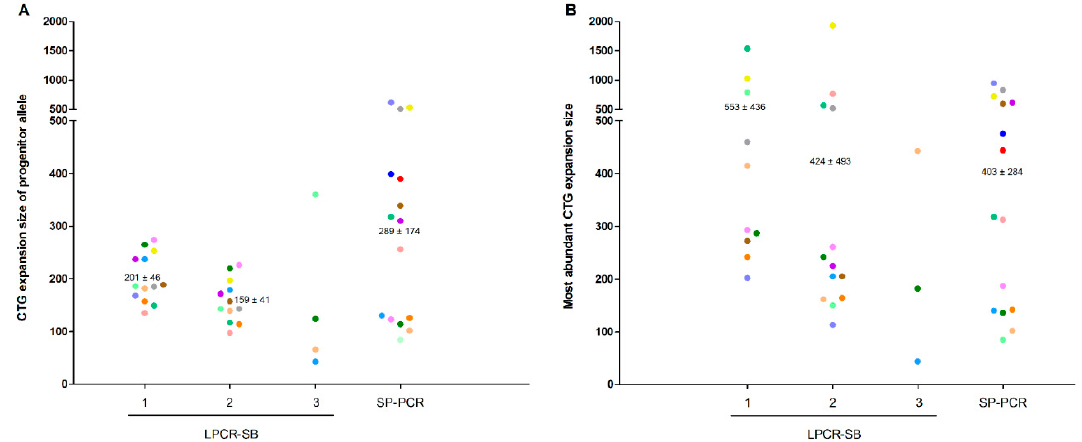
Figure 2. CTG expansion size of the progenitor allele ( A ) and the mode allele ( B ) for each technique. The progenitor allele was estimated by the lowest signal yielded after WT range for LPCR-SB, and by the most frequent lower band present in the samples for SP-PCR. Mode allele was estimated by the more intense signal yielded by LPCR and the most abundant band for SP-PCR. Data for heat pulse extension-polymerase chain reaction are not shown owing to the inconsistency of the results. All valid individual data within the detection limit (2000 CTGs) are shown(di ff erent color per patient). Normality was analyzed with the Kolmogorov–Smirnov test and we used a repeated-measures one-way analysis of variance (ANOVA) test for performing within-subject comparisons between methods. No significant group (or ‘method’) e ff ect was found for the progenitor allele ( p = 0.112) or the mode allele ( p = 0.653). Mean and SD values are shown only for those methods included in the within-subject analyses (i.e., LPCR1, LPCR2 and SP-PCR). A significant Pearson correlation was found between the progenitor allele of LPCR1 and LPCR (indicated by an *symbol in the Figure, r = 0.983 [95% confidence interval (CI) 0.940 to 0.996], p < 0.0001). Y-axis scale is segmented from 500 CTGs to 2000 CTGs, representing 25% of the total length axis. Abbreviations: LPCR—long polymerase chain reaction; SP-PCR—small pool polymerase chain reaction.